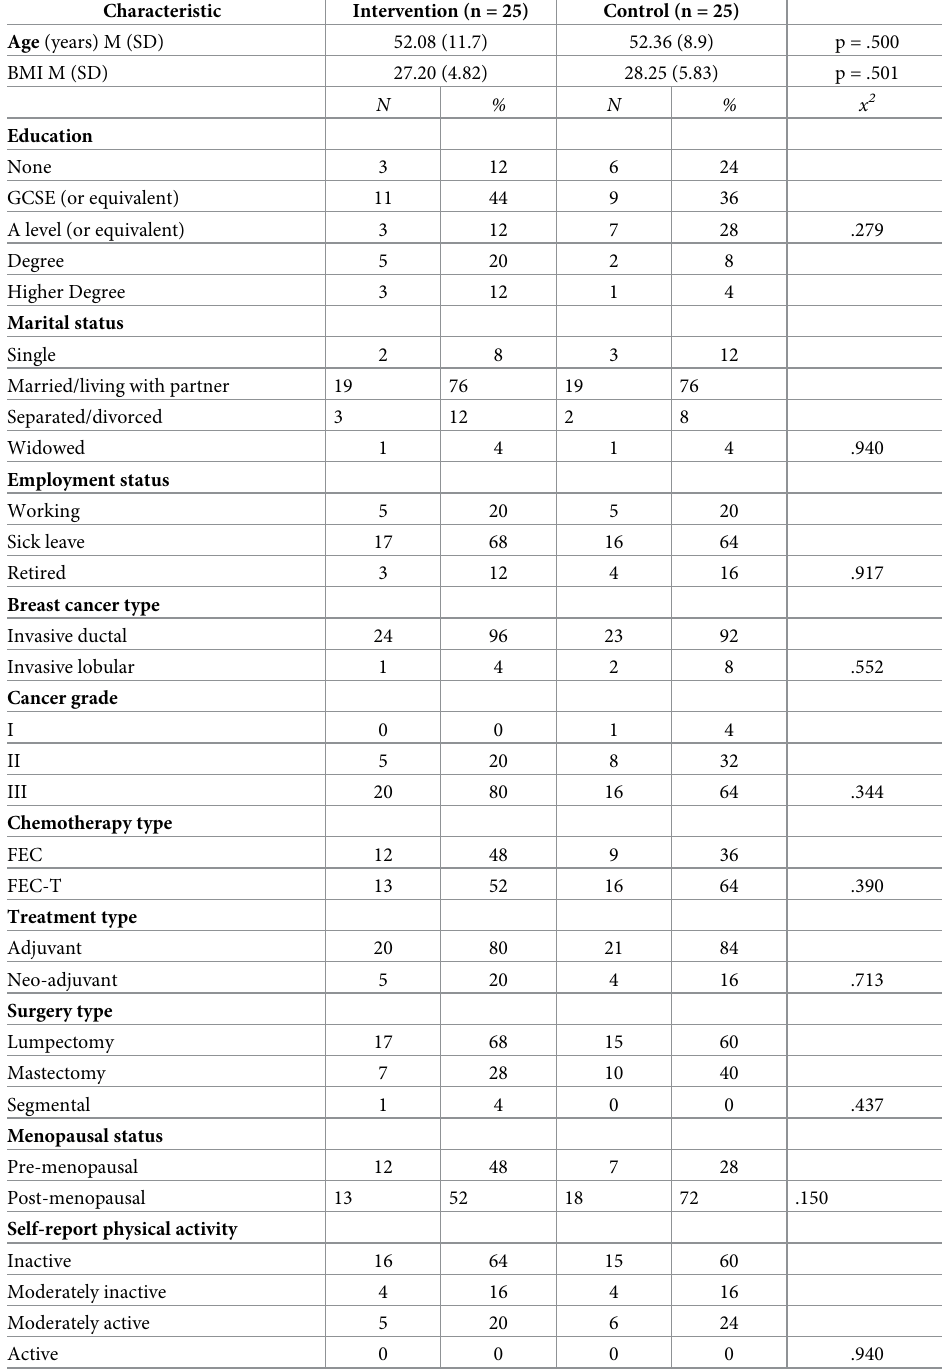
Table 1. Demographic and treatment characteristics for intervention and control